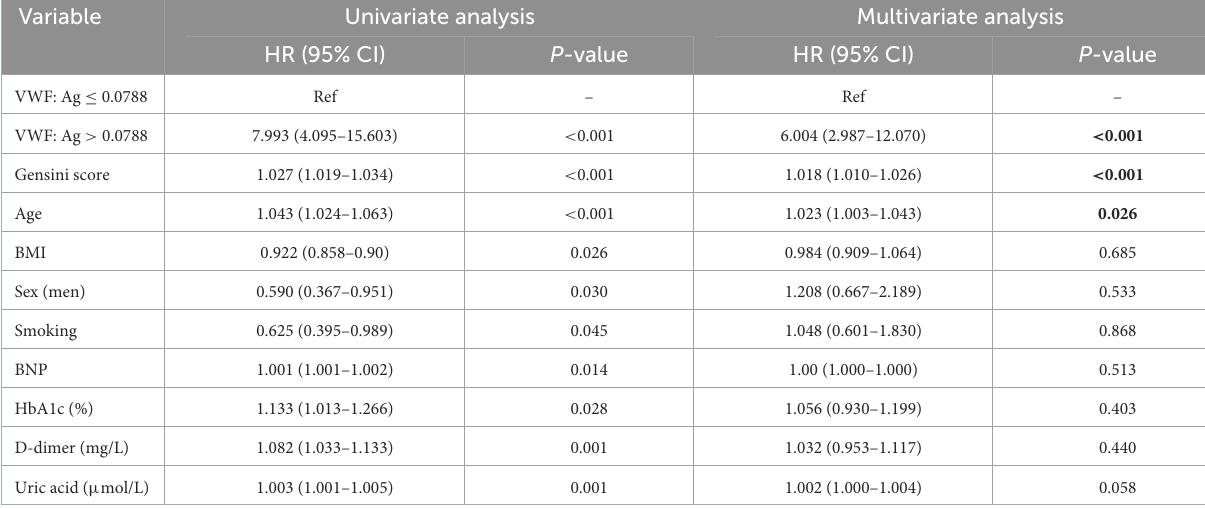
TABLE 4 Univariate and multivariate Cox regression analyses predicting the occurrence of MACEs in patients with AMI after 2 years of follow-up. Variable Univariate analysis Multivariate